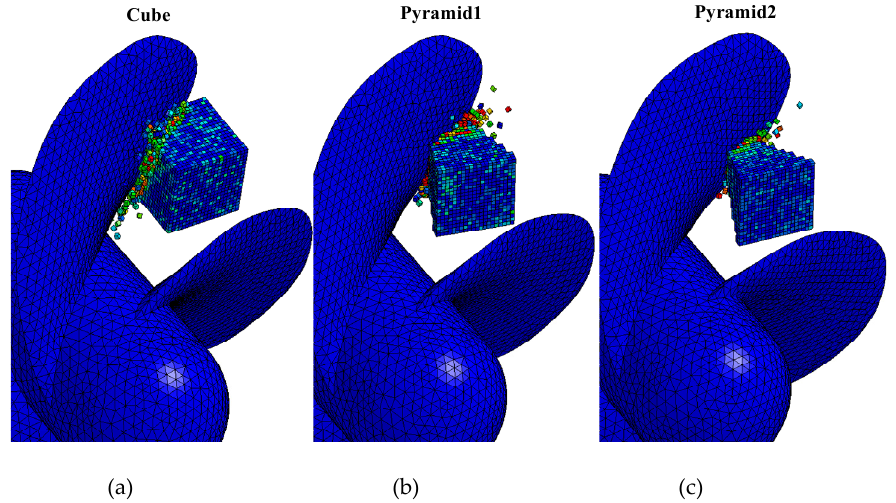
Figure 29. Time series of ice speed in the x direction based on simulations with di ff erent ice blocks.